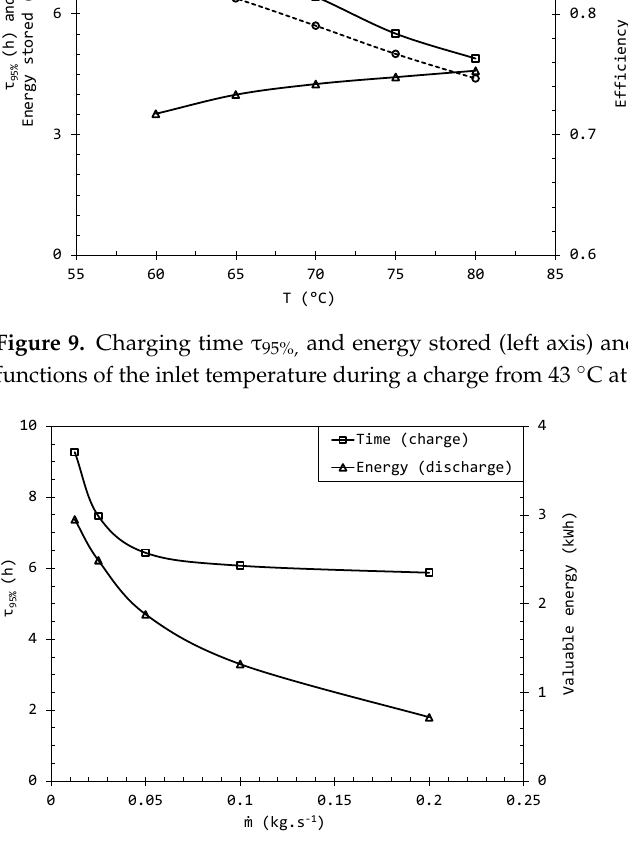
Figure 10. Charging time τ 95% (left axis) and valuable discharged energy above 45 °C (right axis) as function of the mass flow rate between 43 °C and 70 °C.